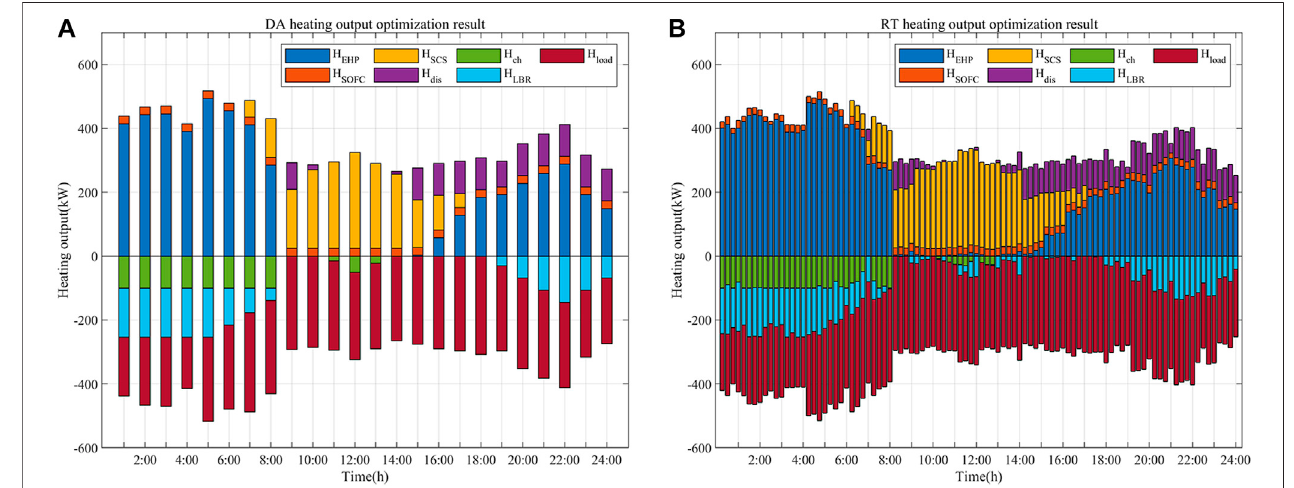
FIGURE 9 | DA and RT heating output optimization result.